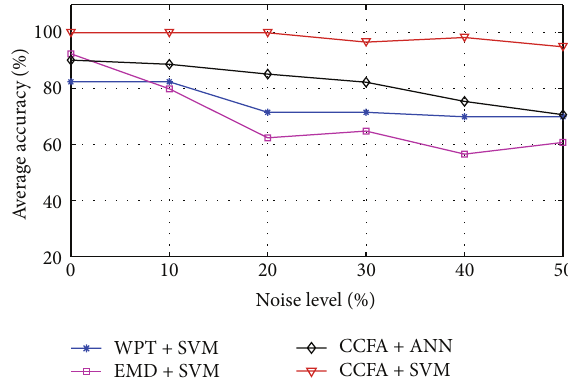
Figure 10: The average accuracies of identification with different level of noises.